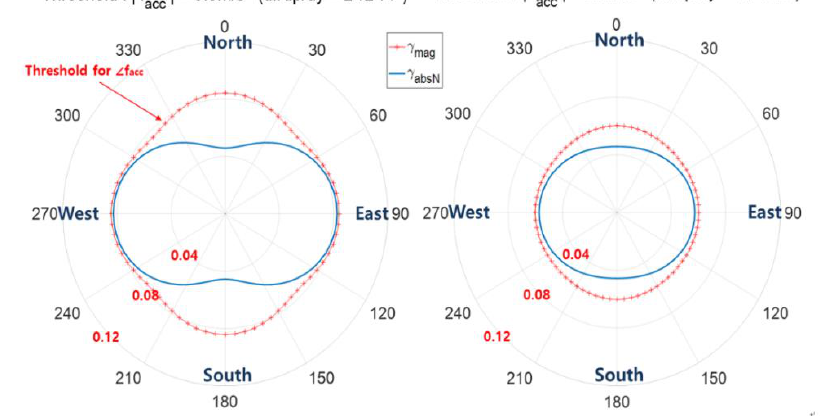
Figure 7. Probability of spoofing detection, P d , mag and P d , absN according to Attitude and Heading Reference System (AHRS) accuracy. Sensors 2020 , 20 , 954 14 of 22